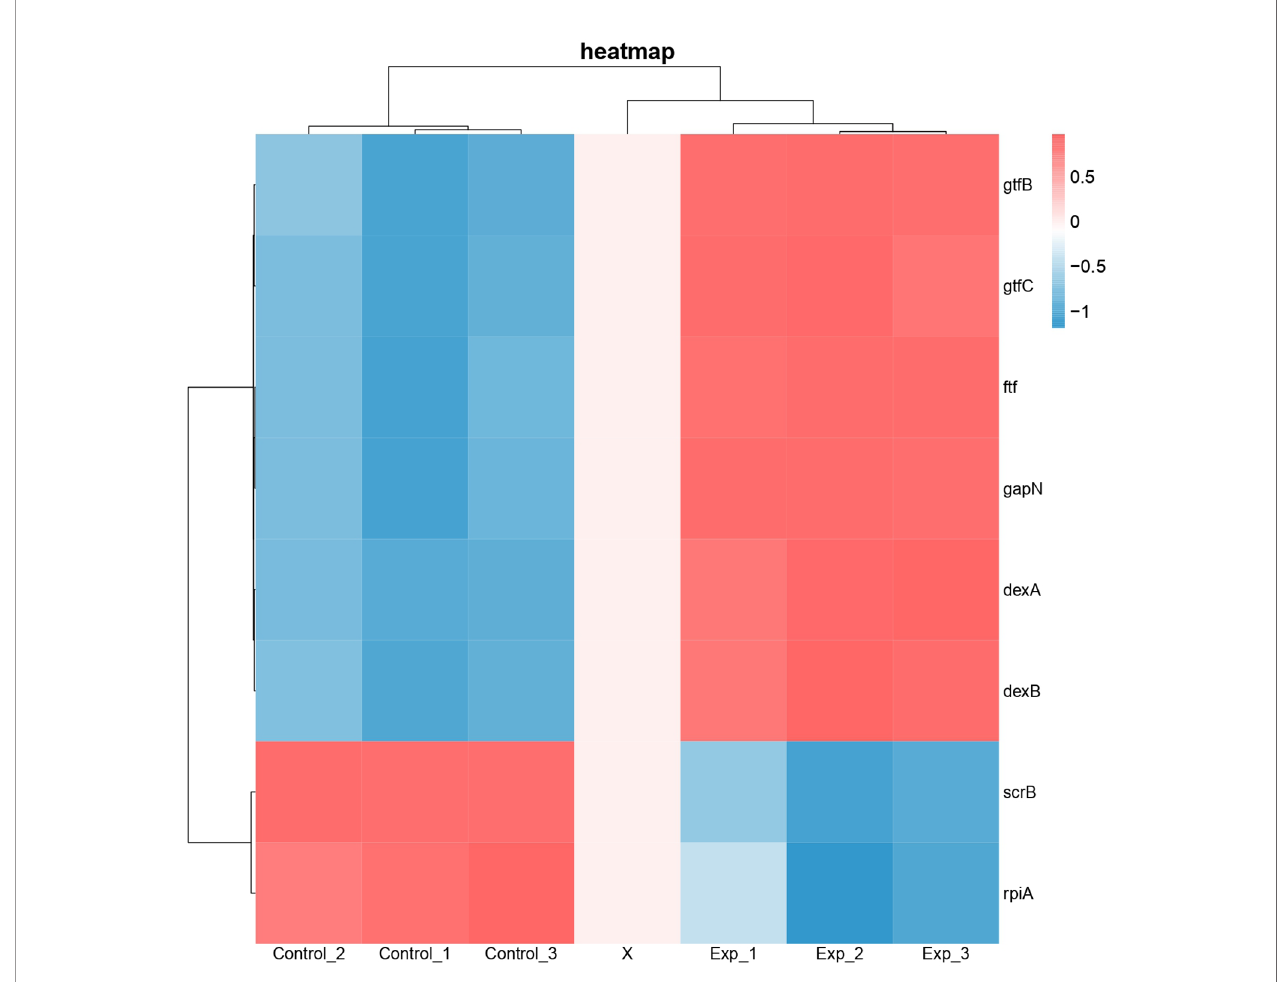
FIGURE 8 | Heatmap of differentially expressed genes associated with protein functions of 3AIC, 2ZID, and 3M7V. Control groups were treated with acetonitrile. Experimental groups were treated with 2 µg/ml of 1,3-bis[3,5-bis(tri fl uoromethyl)phenyl]urea (BPU). Genes gtfB , gtfC , ftf , dexA , dexB , and scrB are involved in exopolysaccharide biosynthesis. Genes gapN and rplA are involved in pentose phosphate pathway. Blue indicates lower expression, and red indicates higher